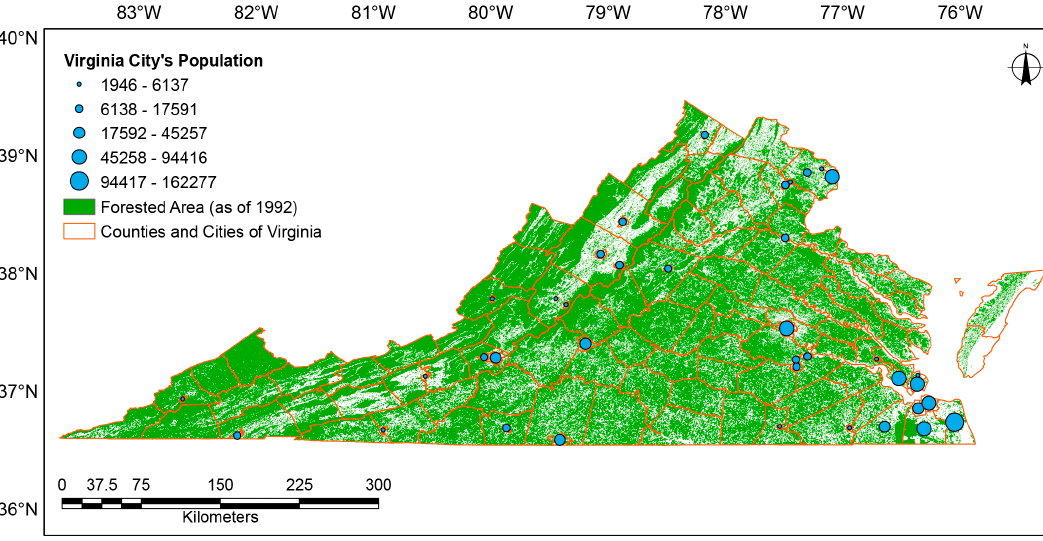
Figure 1. Study area, the Commonwealth of Virginia, USA.